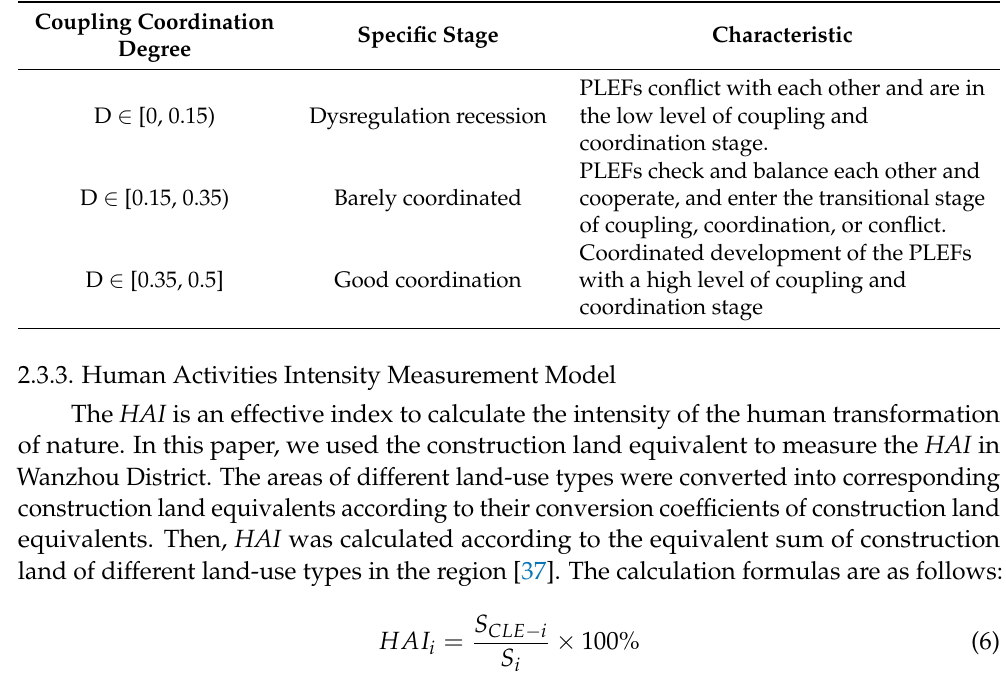
Table 3. Stage division of the CCD of the PLEFs.